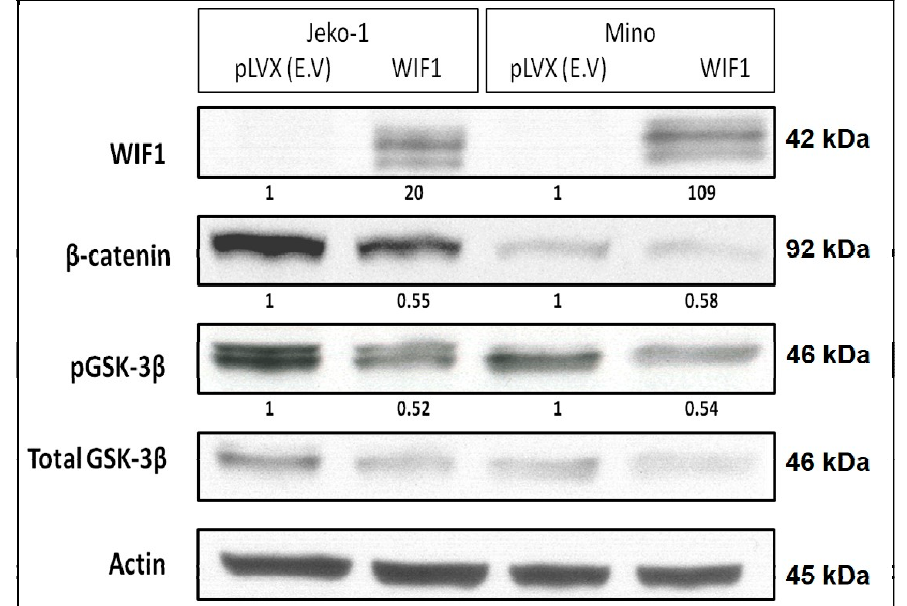
Figure 4. The expression of several markers of the Wnt canonical pathway was down-regulated 48 h after the gene transfection of WIF1. The densitometry readings of individual bands on the Western blot are shown.